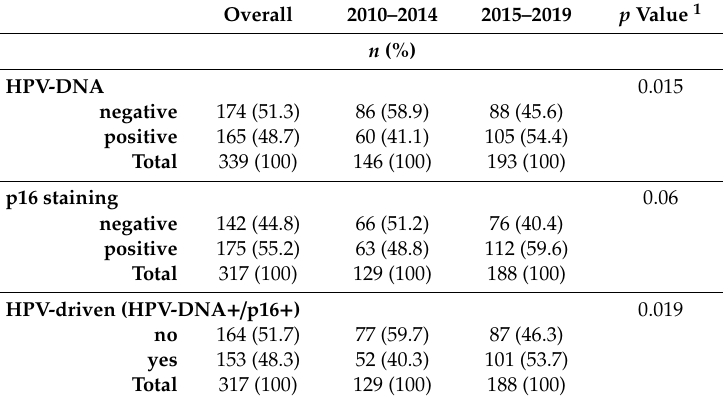
Table 2. HPV-DNA status, p16 positivity and HPV-driven OPSCC cases overall and according to the period of